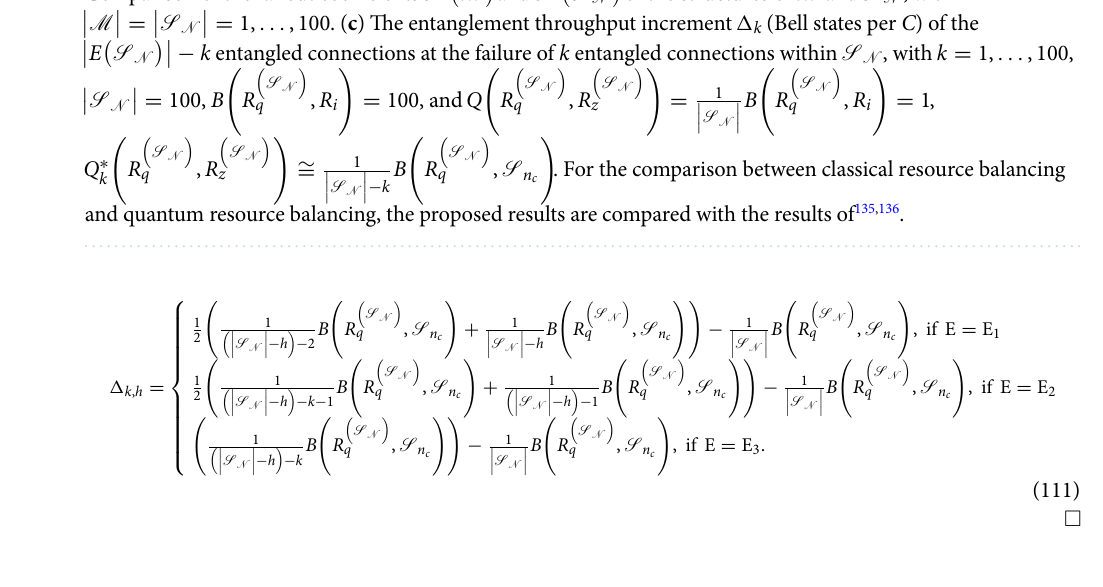
Figure 6. ( a ) Comparison of the amounts of traffic T and B (Bell states per C ) within the structures of M and S N , with T Comparison of the fanout coefficients F and F of the structures of M and S N ,